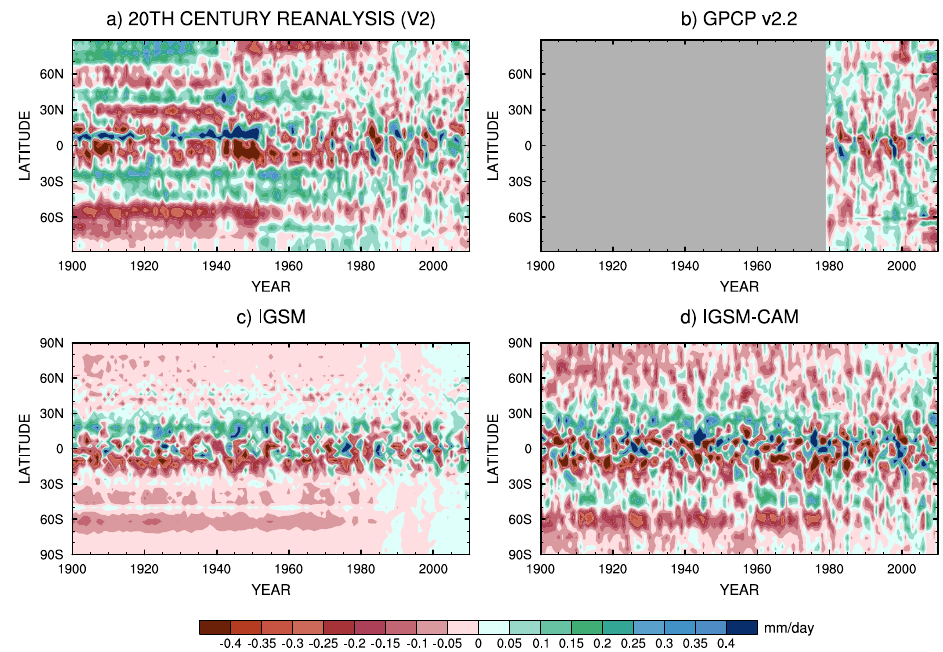
Fig. 10. Hovmöller diagrams of zonal-mean precipitation anomalies from the 1981–2010 mean (mmday − 1 ) for the IGSM and IGSM-CAM simulations, under median climate sensitivity, and for the GPCP v2.2 and 20CR